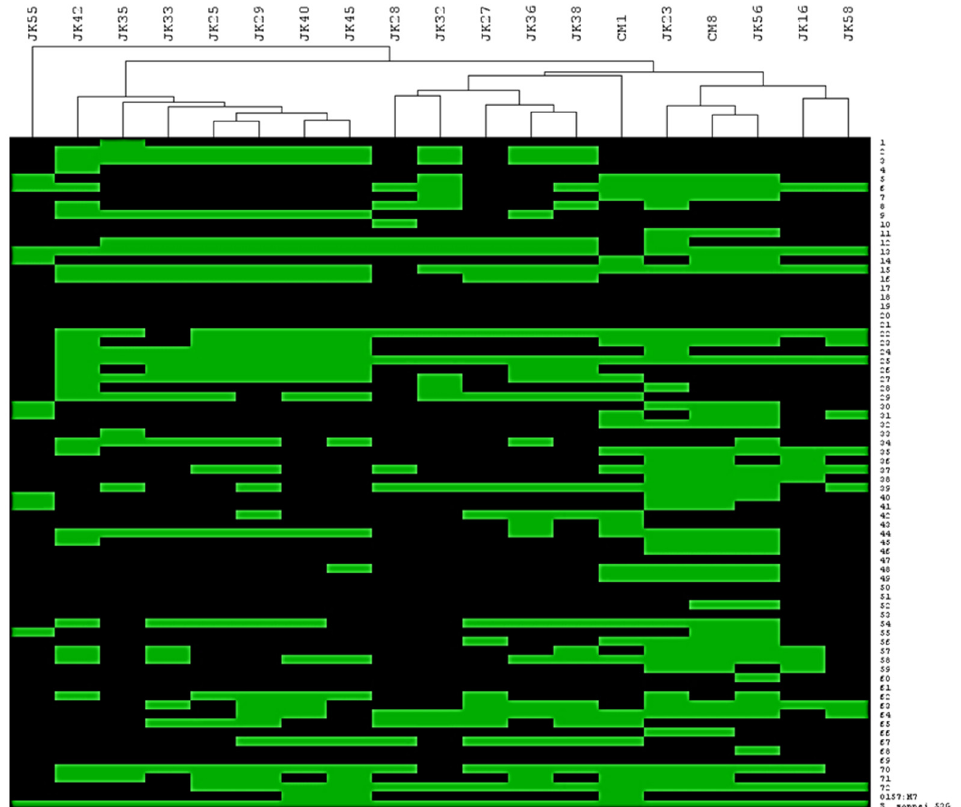
Figure 1. Hierarchical clustering of isolated phages depending on their host range; 72 ECOR strains, E. coli O157:H7 ∆ stx strain and S. sonnei 53G strain; green box represents successful phage infection and black box - no